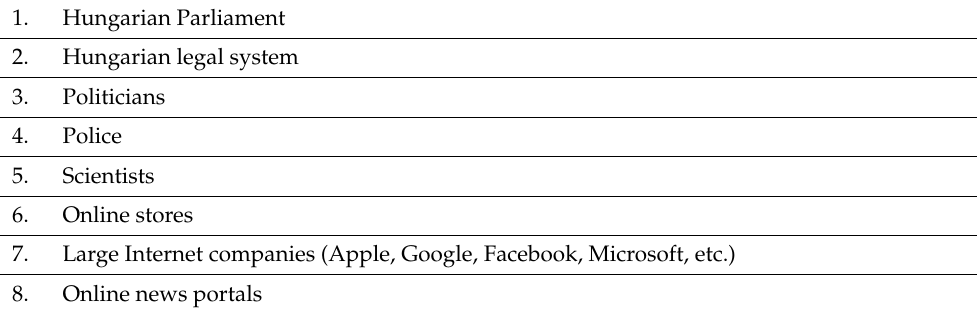
Table A4. The list of institutions, about which we asked the respondent how much they trust in